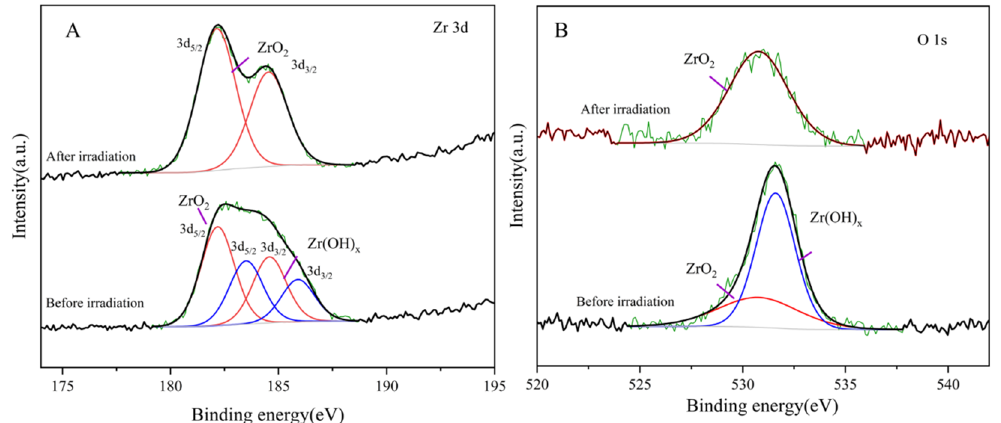
Figure 4. XPS of the ( A ) Zr3d region and ( B ) O1s region of InP/ZnSe/ZnS:Zr (S/Zr = 1:4) QDs before and after light